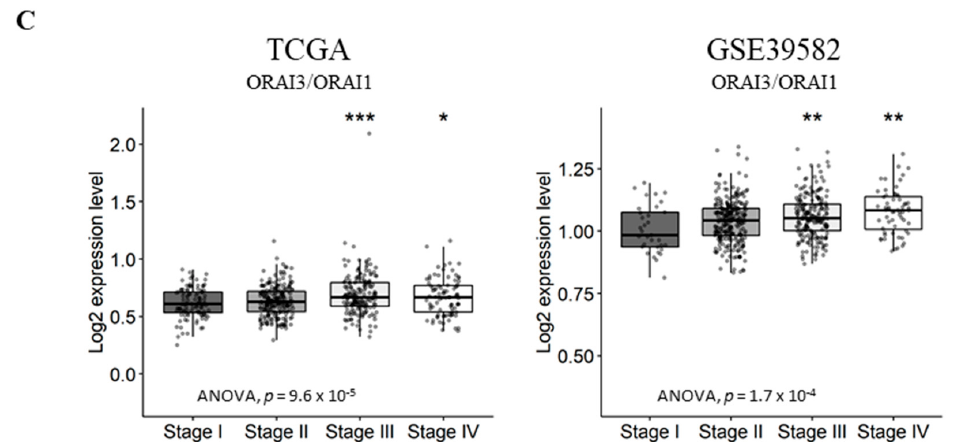
Figure 6. ORAI3 / ORAI1 ratio predicts poor prognosis in CRC. High and Low scores were attributed to patients using ratio ORAI3 / ORAI1 median expression as a threshold. High and Low categories were done using a Log-Rank test; ( A ) OS and EFS survival curves of ORAI3 / ORAI1 ratio in the TCGA dataset. ( B ) OS and RFS survival curves of ORAI3 / ORAI1 ratio in the GSE39582; ( C ) ORAI3 / ORAI1 ratio expression according to tumor stages. The ANOVA test was used for multiple comparisons. The BH-adjusted student t -test was used for pairwise comparisons (Stage I was considered a reference). (* p < 0.05; ** p < 0.01; *** p < 0.001).